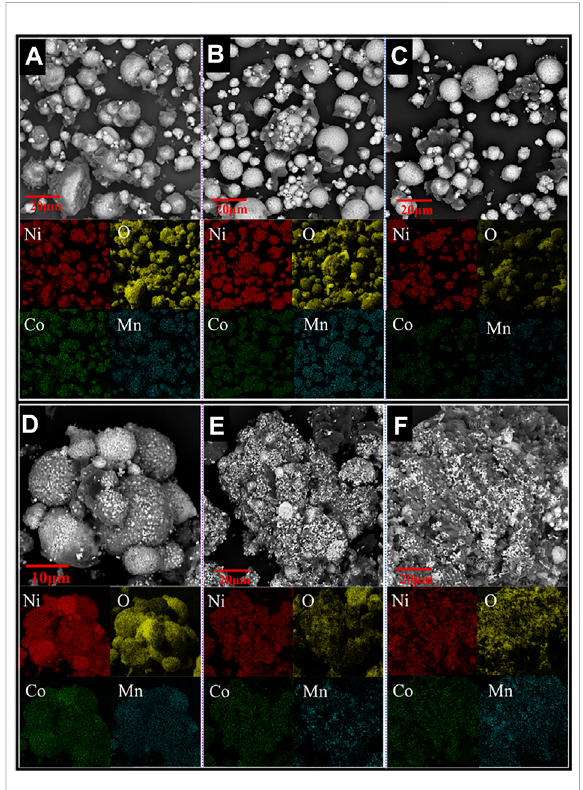
FIGURE 4 SEM and elemental mapping images of samples obtained at intermediate reduction temperatures of (A) 420 ° C, (B) 450 ° C, (C) 475 ° C, (D) 553 ° C, (E) 685 ° C, and (F) 880 ° C (Heating rate 20 ° C/min, H 2 concentration 20